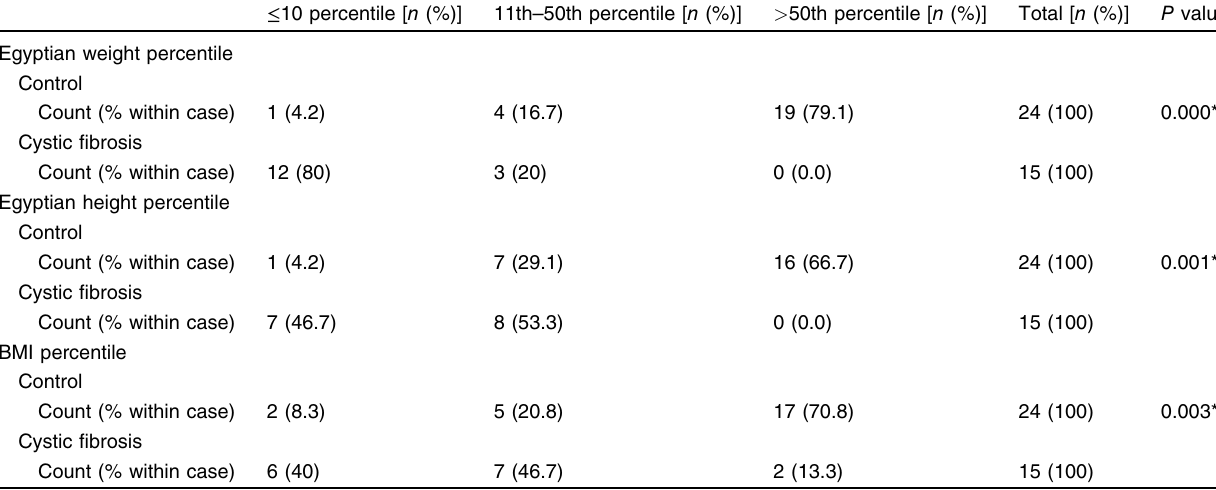
Table 2 Egyptian growth percentiles in patients and controls